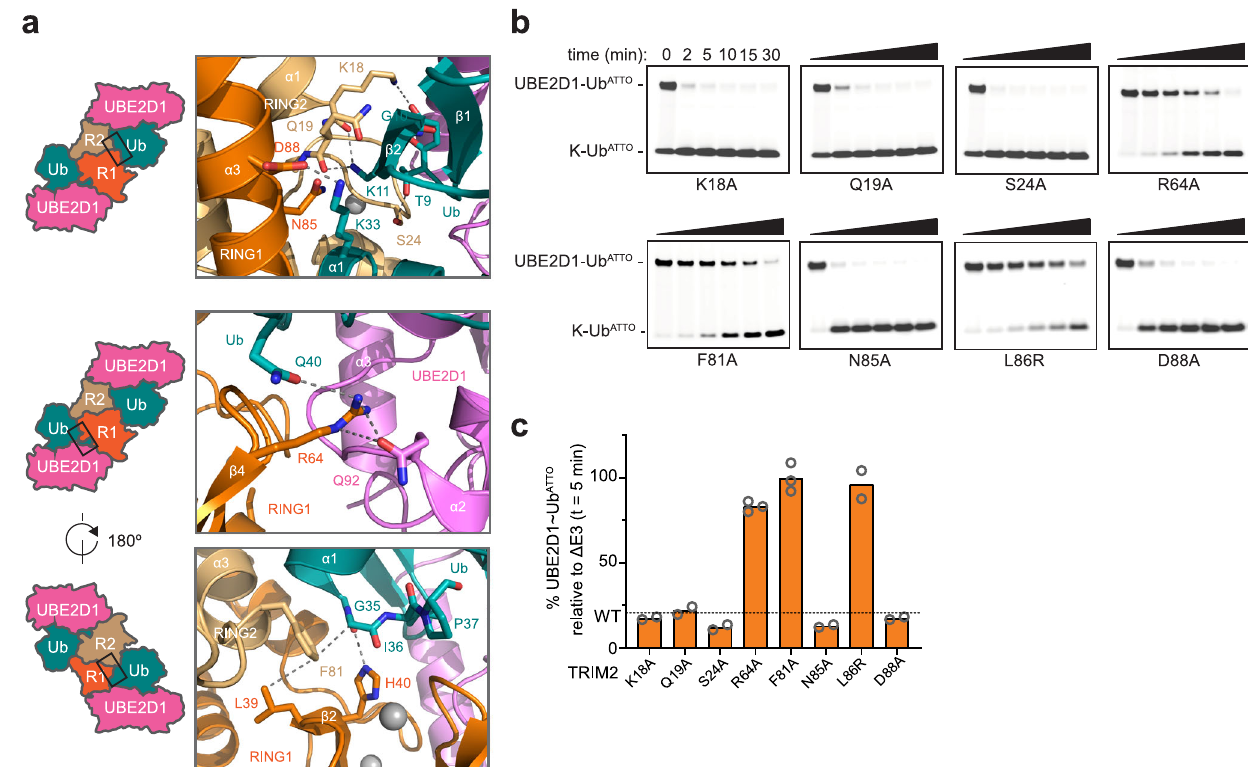
Fig. 3 | TRIM2/E2~Ub interaction. a Close-up of the interfaces between TRIM2 RING domain and the UBE2D1~Ub conjugate highlighted on a graphical illustration of the complex. Protein coloring is the same as in Fig. 2. b Lysine-discharge assay showingthedisappearanceofthebandforthe fl uorescentlabeledUb ATTO loadedE2 in the presence of TRIM2 RING mutant constructs. Reactions were carried over a 30-min time interval. c Quanti fi cation of the UBE2D1~Ub ATTO band after 5-min